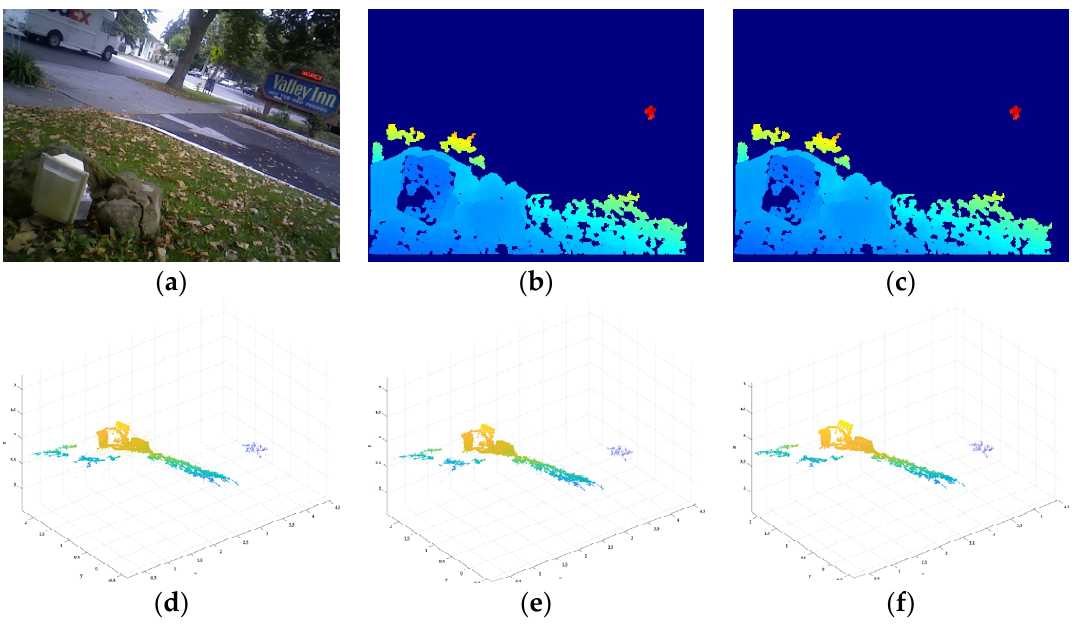
Figure 12. Denoising effects of fractional integral denoising and median filtering. ( a ) RGB image